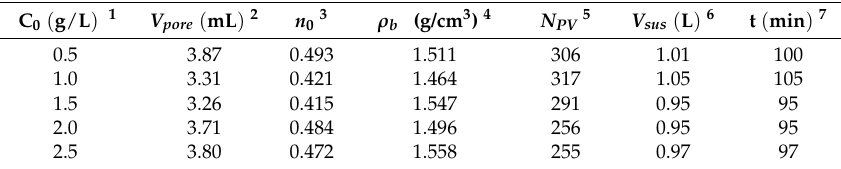
Table 2. Experimental conditions of continuous injection